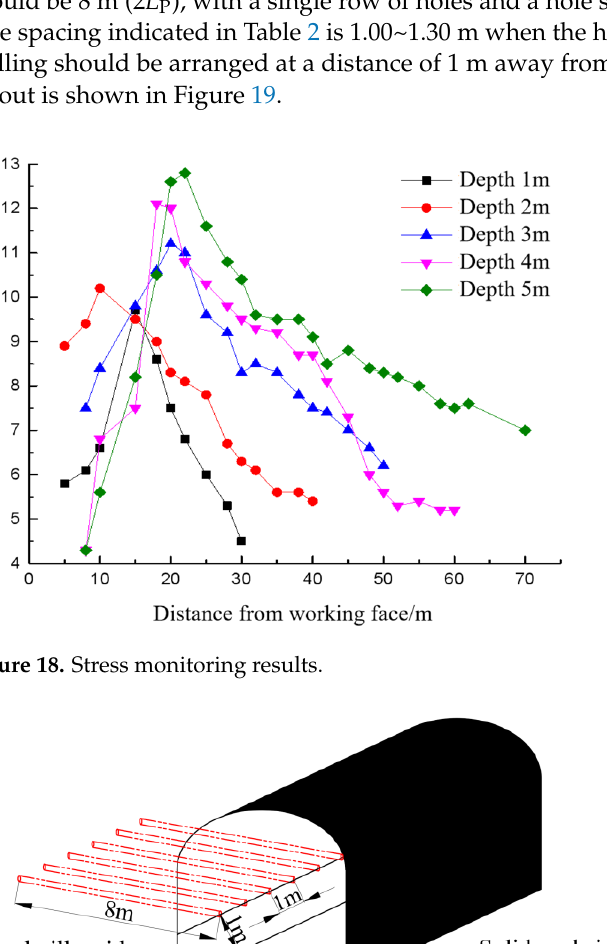
Figure 18. Stress monitoring results.